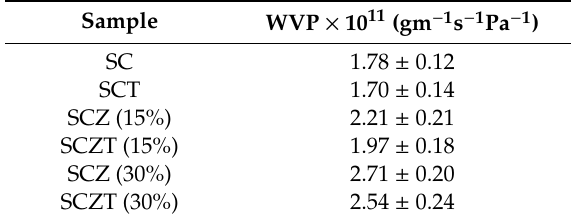
Table 2. Water vapor permeability of the control and impregnated